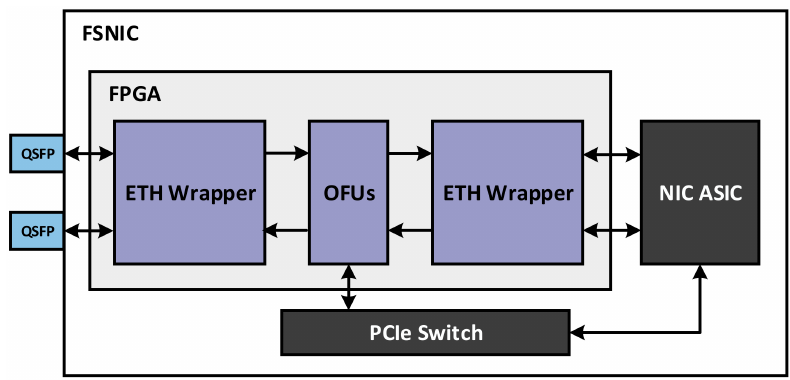
Figure 4. Hardware architecture